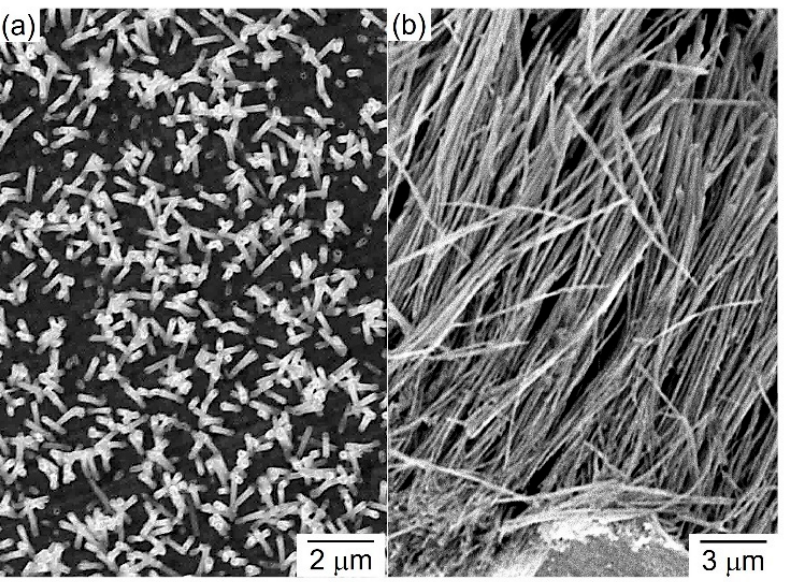
Figure 9. SEM images of the ZnTe nanowires array that were electrodeposited into the